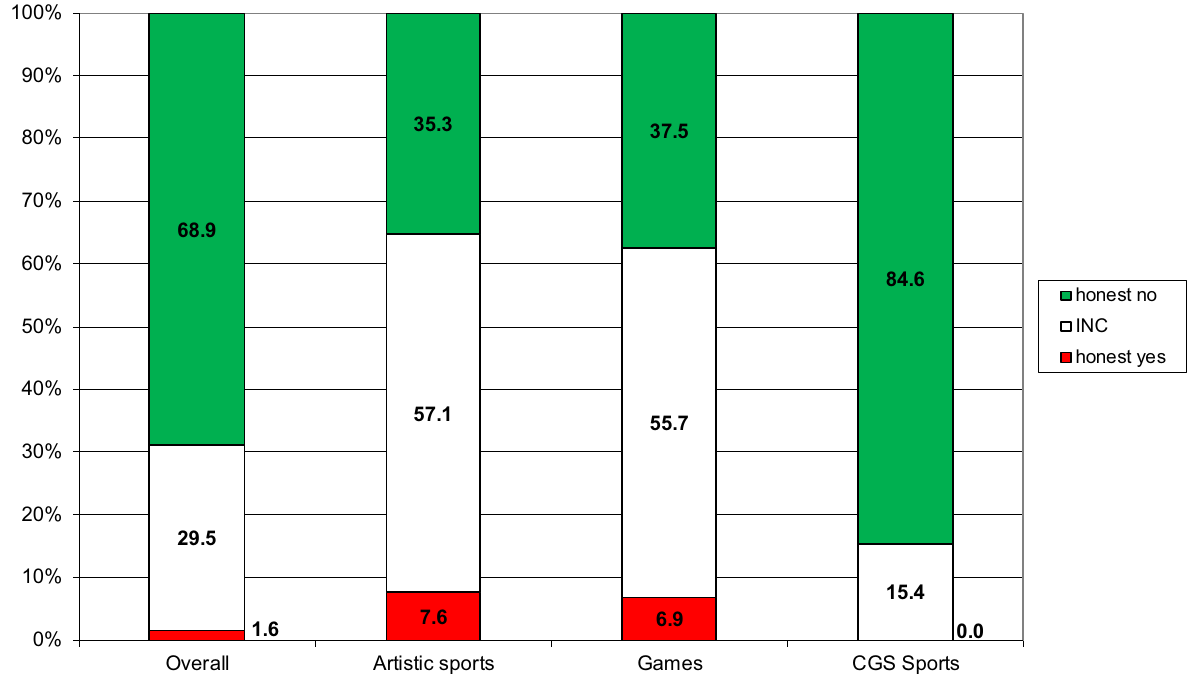
Fig. 6 Estimates for the prevalence of doping overall and in Artistic sports, Games, and CGS sports. CGS seconds. INC Instruction =